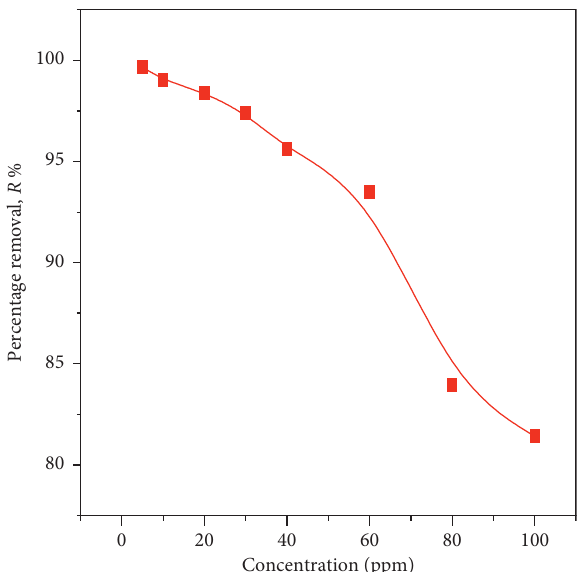
Figure 5: Effect of initial dye concentration on the adsorption onto AC.